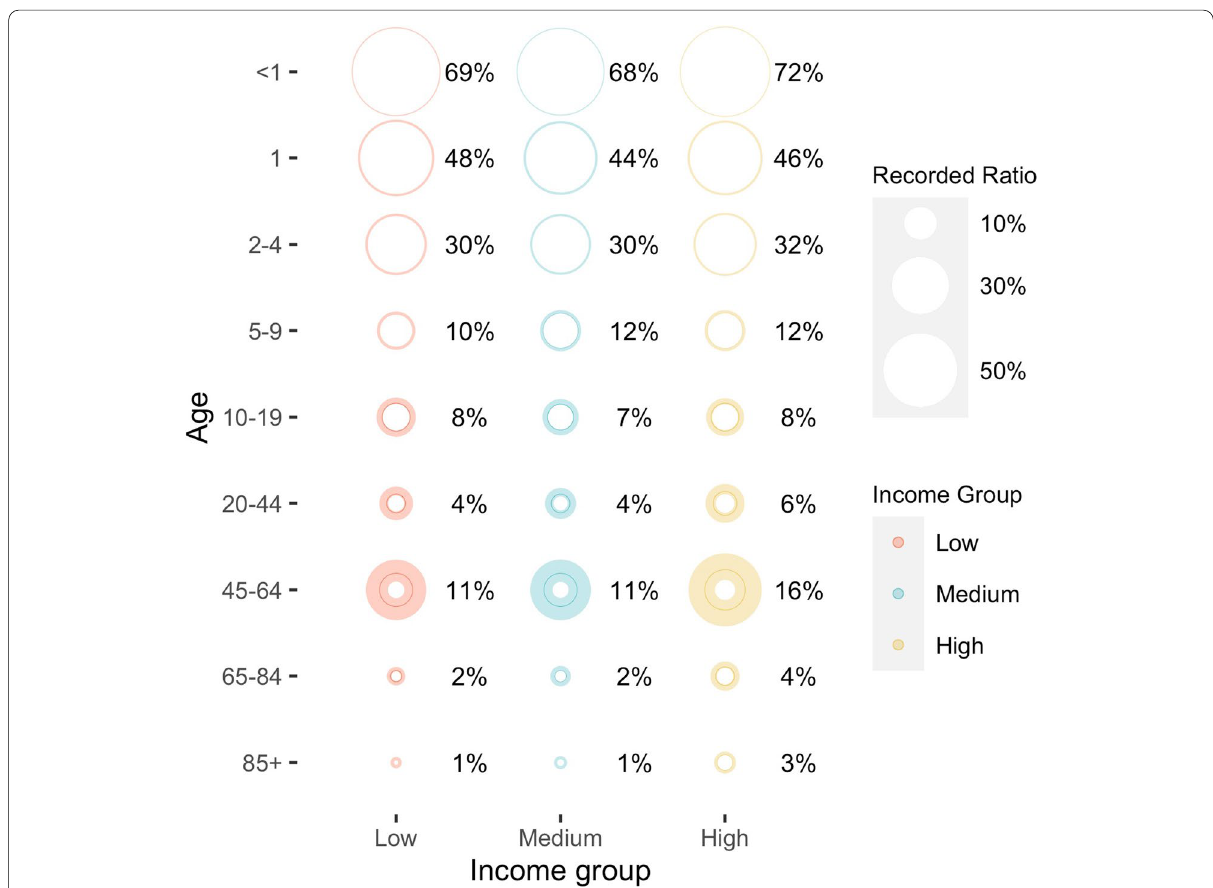
Fig. 2 Ratio of the number of annual hospitalizations recorded as being due to RSV and the number of estimated annual RSV hospitalizations, by age and SES group, July 2005—June 2014. The size of the circles represents the estimated proportion of hospitalizations caused by RSV that were recorded. The texts show the mean estimates of the recording ratio in each age and SES group. The shaded areas indicate the 95% credible intervals of the reporting ratio. Color blue, yellow, and red correspond to the estimates in populations from low, medium, and high SES ZIP